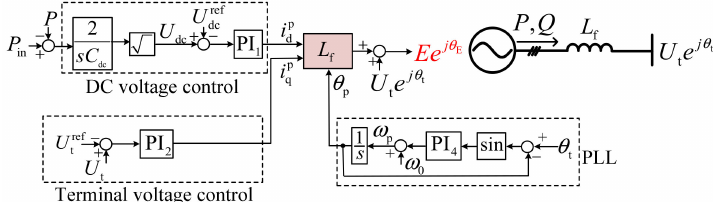
Figure 6. Relationship between control loops and the dynamics of internal voltage in the DVC